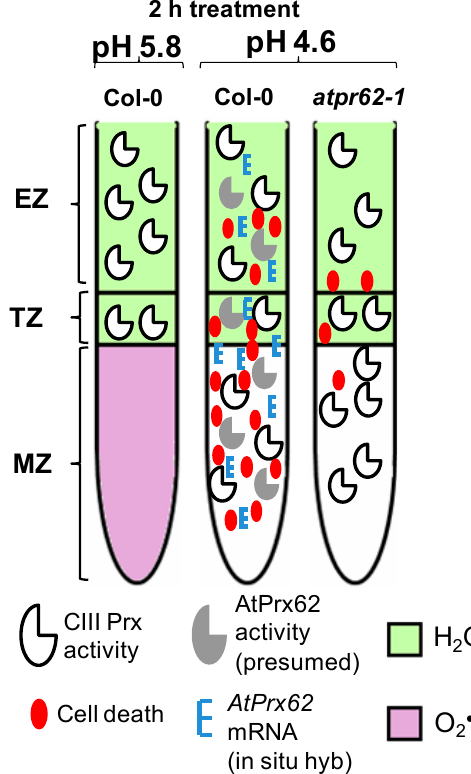
Figure 6. Spatio-temporal model proposed for the action of AtPrx62 in roots of A. thaliana upon low pH and the progression of cell death. In Columbia-0 (Col-0) roots, a reliable spatio-temporal correlation was observed in EZs, TZs, and MZs between low pH-induced CIII Prx activity (total activity: without distinction among the isoforms), AtPrx62 mRNA distribution, and cell death. The low-pH-induced cell death and AtPrx62 mRNA accumulation were highly decreased in roots of atprx62-1 KO mutant indicating that AtPrx62 was positively involved in the progression of low pH-induced cell death. However, no decrease could be measured for the CIII activity in atprx62-1 .